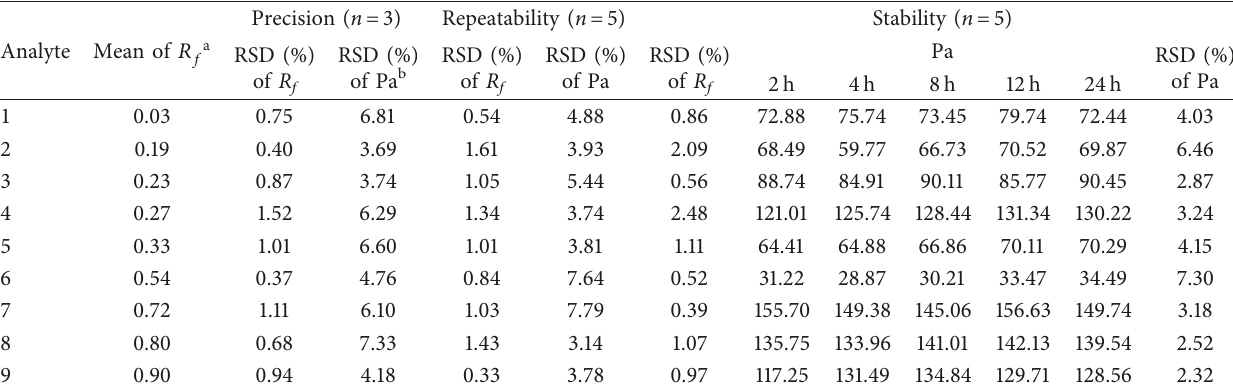
Table 3: Precision, repeatability, and stability of nine analytes in